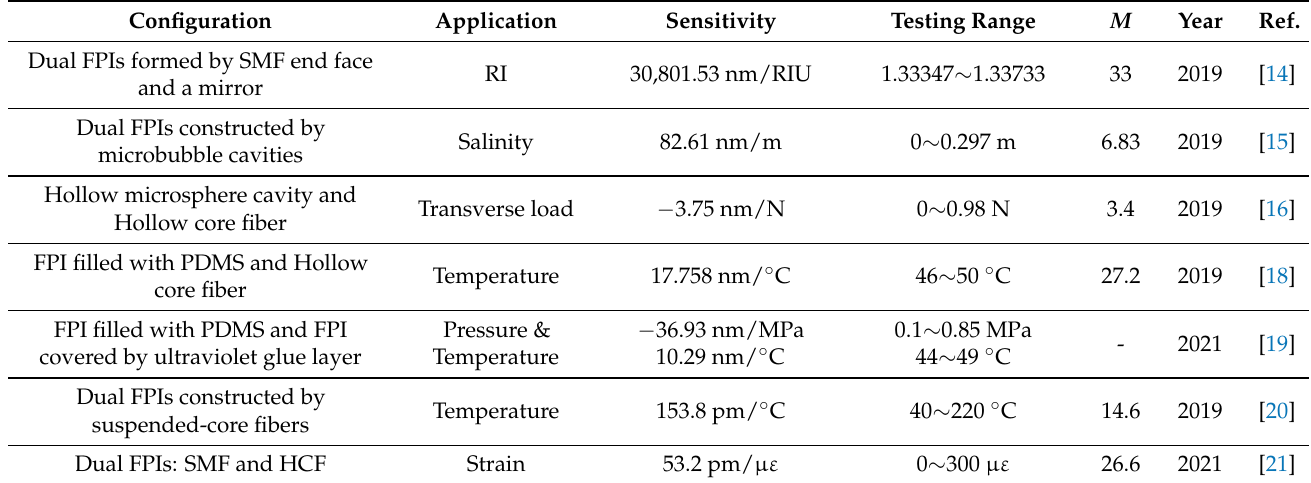
Table 1. Summary of the Paralleled FPI Fiber Sensors with the Vernier